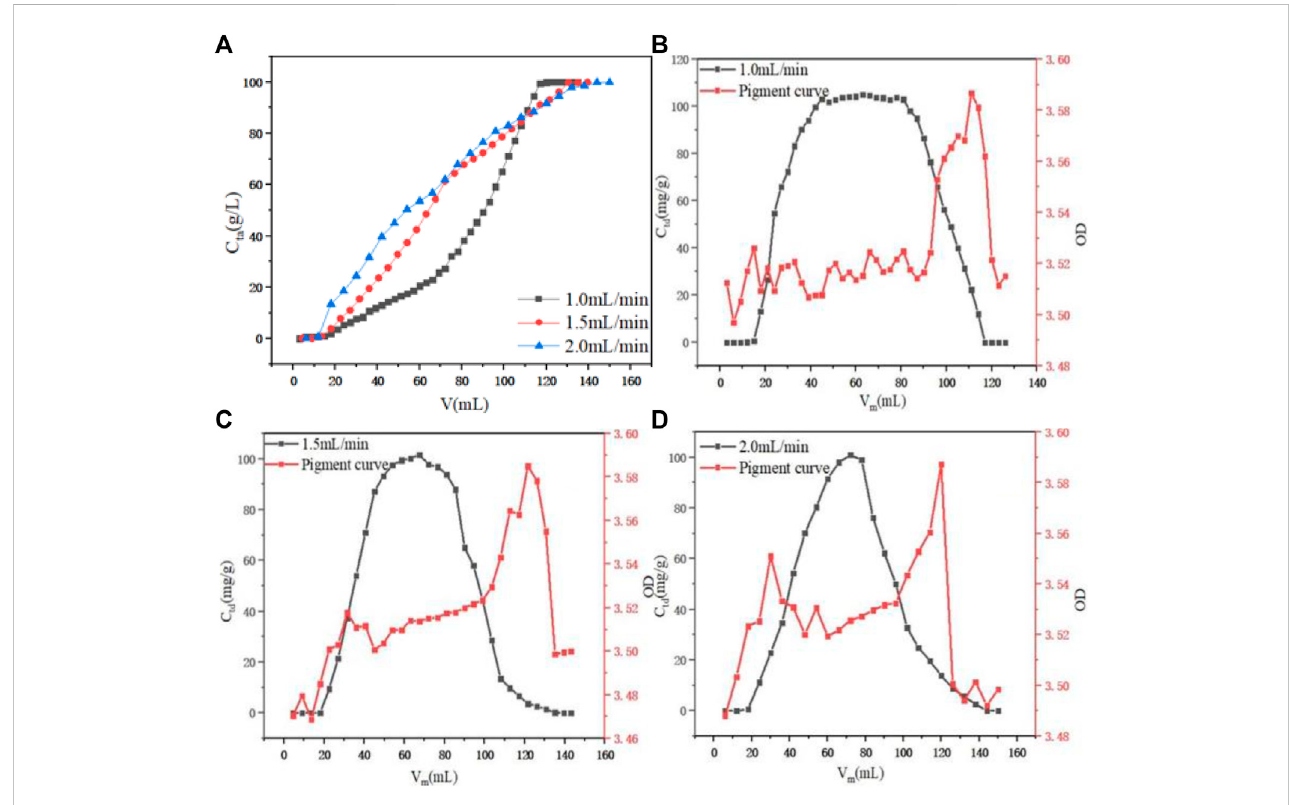
FIGURE 6 (A) Effect of fl ow rate on dynamic adsorption. (B) Effect of 1.0 ml min − 1 on dynamic desorption. (C) Effect of 1.5 ml min − 1 on dynamic desorption. (D) Effect of 2.0 ml min − 1 on dynamic